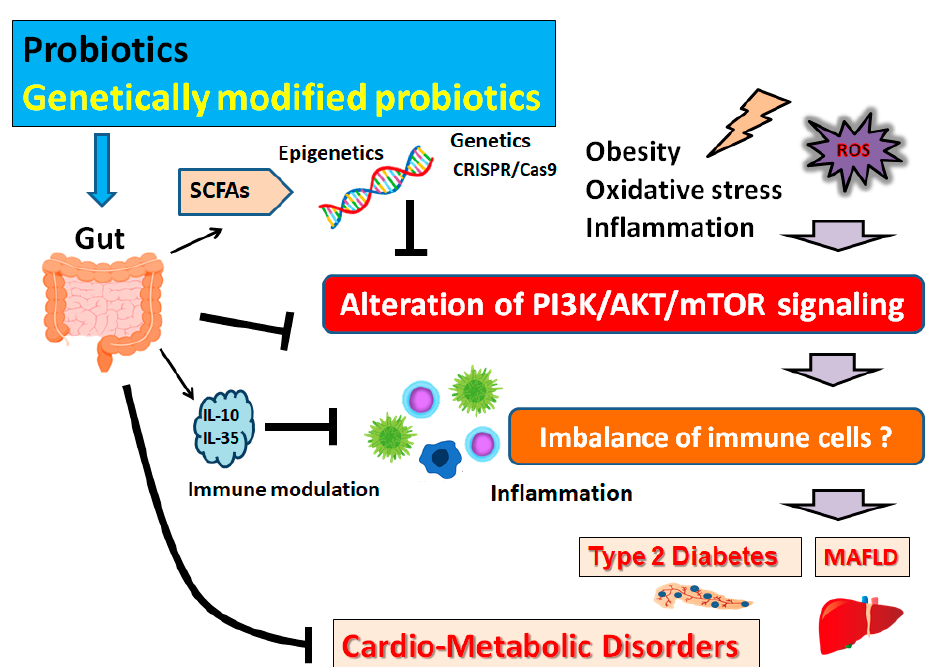
Figure 2. Schematic representation of the inhibition of the pathogenesis of cardio-metabolic disorders. Some types of probiotics and/or genetically modified probiotics could contribute to the alteration of gut microbial community for playing valuable roles in inhibiting the PI3K/AKT/mTOR signaling pathway in part via the epigenetics regulation with SCFAs. Examples of certain beneficial microbial species with several effects on anti-cancer immune responses are shown on the left side. Arrowhead indicates stimulation whereas hammerhead shows inhibition. Note that several important activities such as cytokine induction and/or inflammatory reactions have been omitted for clarity. Abbre- fatty